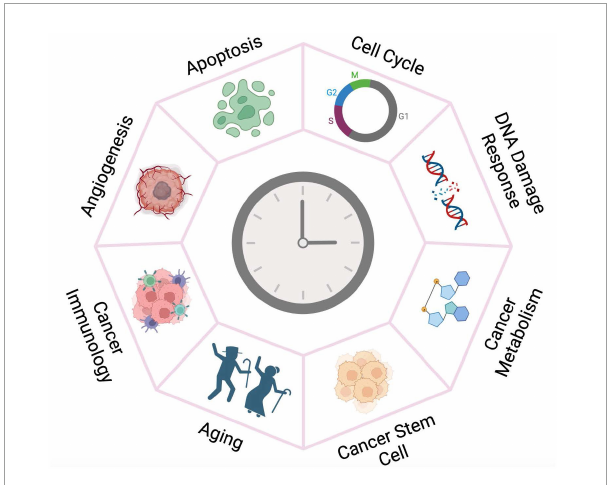
FIGURE2 The circadian clock plays versatile roles in cancer development. The circadian clock machinery is reprogrammed by oncogenic pathways and chromatin remodeling in cancer tissues, thereby gaining fundamental functions in cancer development.